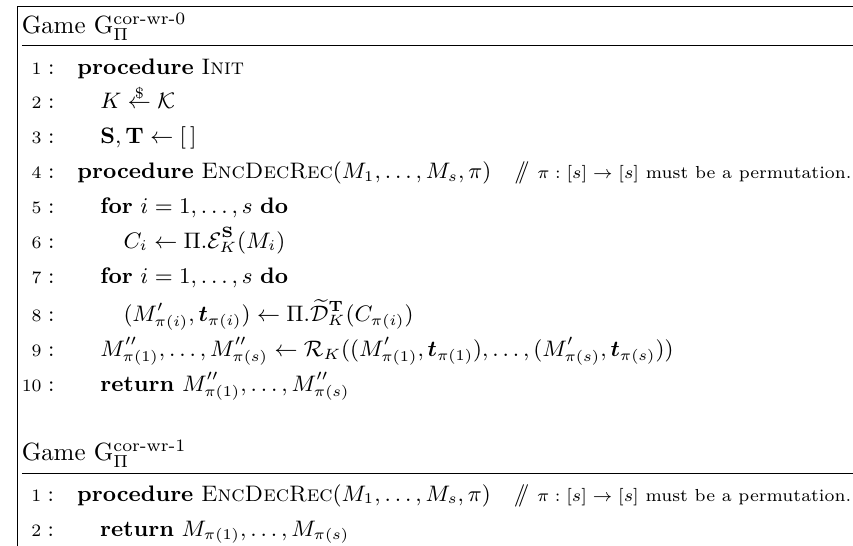
Figure 3: Games defining correctness with reordering of an R-LPSE scheme